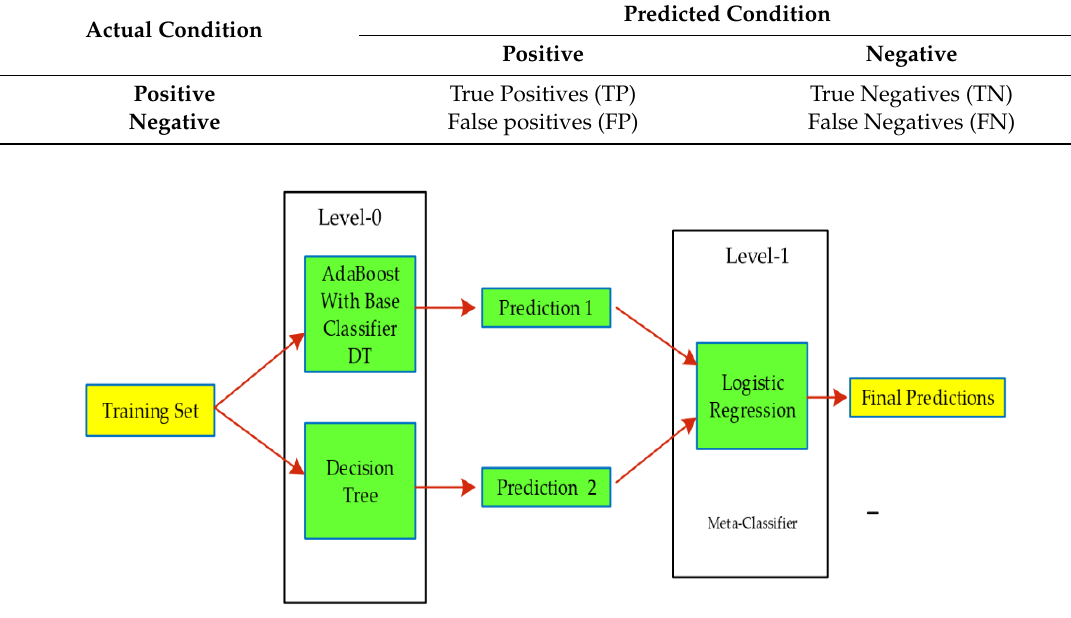
Figure 5. Schematic generalization of stacked framework.